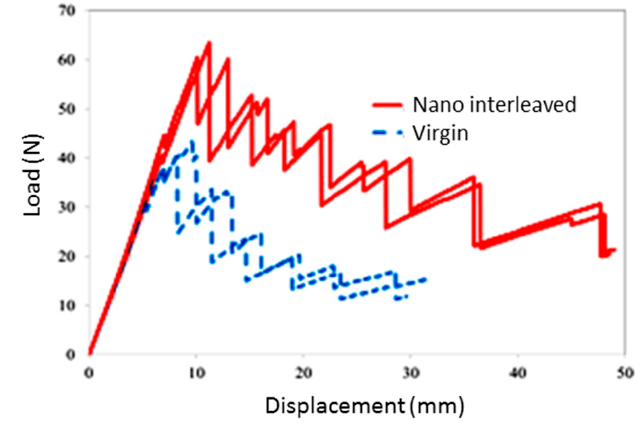
Figure 3. Load–displacement curves of the static tests.